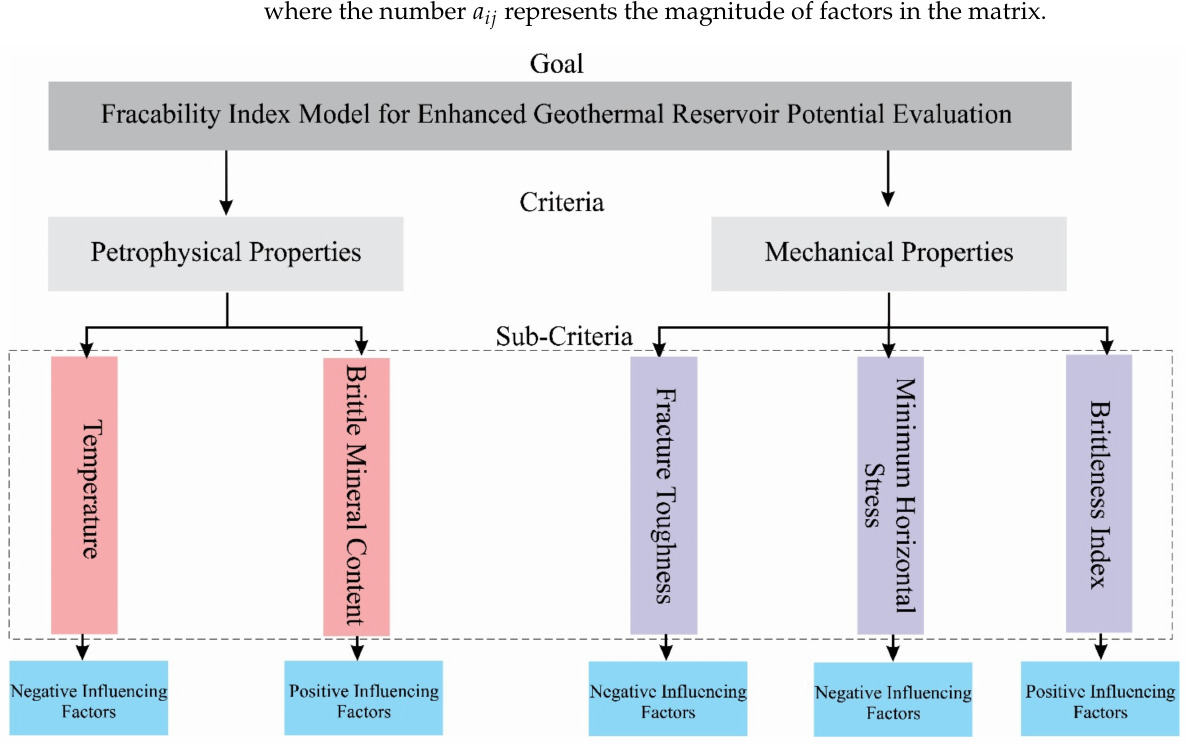
Figure 4. The hierarchical framework of the variables influencing the fracability of rock. Table 2. Factor contribution numerical scales based on experience and judgment.